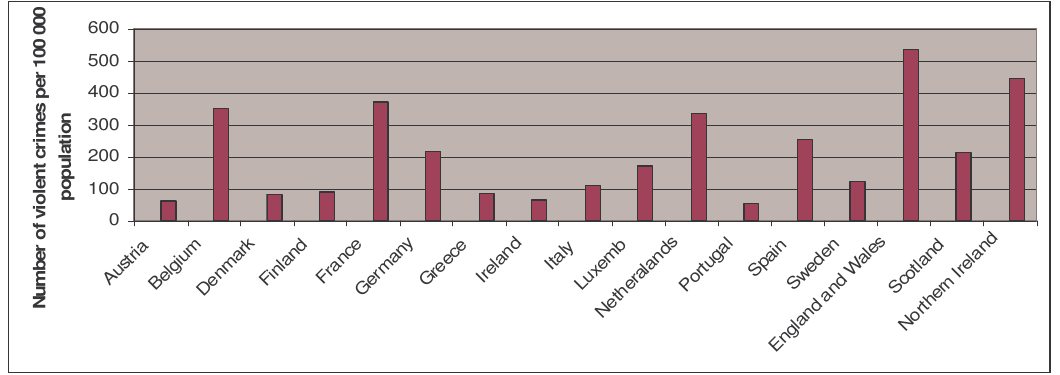
Figure 3. Rate of violent crimes (serious assault, robbery and violent theft) per 100 000 population in 2000 in EU15 (source: